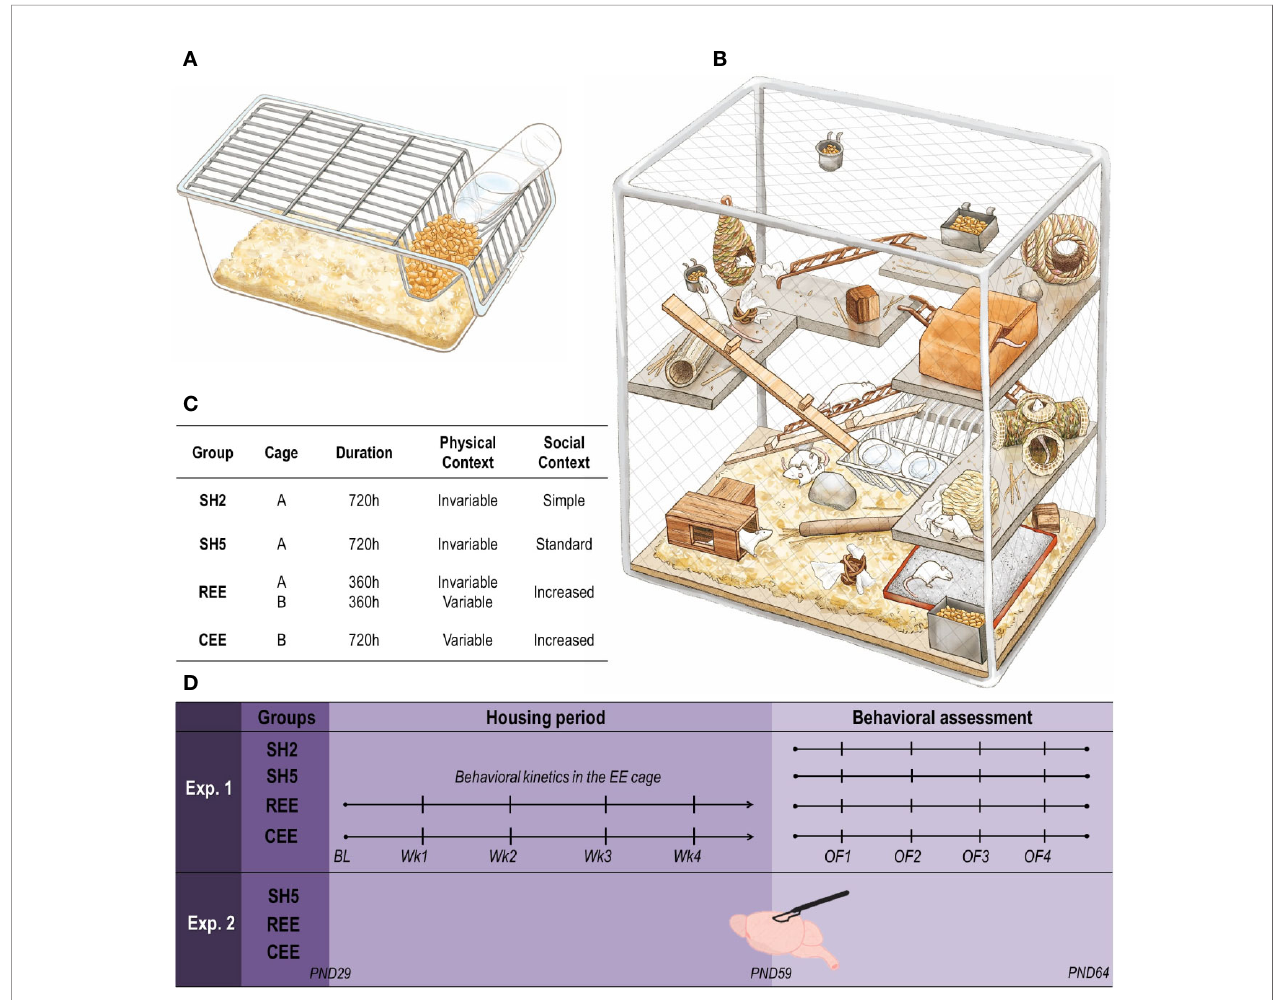
FIGURE 1 | Housing conditions and experimental design. (A) Transparent, polycarbonate cage (56 cm × 35 cm × 20 cm) fi lled with ~5 L of bedding for standard housing (SH). (B) Custom-made (135 cm × 68 cm × 110 cm), environmental enrichment (EE) cage surrounded by wire-mesh walls consisting of four stainless steel levels interconnected by metal and wooden stairs. The cage contained dens, hideouts, nesting and chewing materials, different objects for sensorimotor stimulation, feeders, and two bottles of water (for details see Table 1 ). The fi rst fl oor was always covered with bedding and had a sandbox. No running wheels were used. (C) Distribution of groups (n = 10 rats per group). SH2: pair-housed rats in SH cages; SH5: fi ve rats per cage in SH cages; CEE: ten rats per cage exposed continuously to EE throughout the 30-days protocol (~720 h), except during bed changes (30 min) when rats were housed in groups of fi ve in SH cages; REE: 10 rats per cage with restricted and unpredictable access to the EE cage during ~360 h (50% of the CEE total time). For the REE rats, the time in the cage was equally distributed between the light and dark cycle, with exposures to the EE cage ranging randomly from 2 to 48 h. During the non-EE periods, these animals were also housed in groups of fi ve in SH cages. CEE and REE rats were housed in independent EE cages. In order to control the increased handling experienced by REE rats, both SH groups and CEE rats were also handled each time REE rats were put in and out the EE cage: while SH2 and SH5 animals were relocated into new cages, CEE rats were group-housed in SH cages ( fi veper cage) during 5 min and then returned into the EE cage. (D) Experimental design. Housing conditions started at postnatal (PND) 29 and continued throughout 30 days. In experiment 1, behavioral activity and USVs within the EE cage were measured once a week (Wk) after bed changes. At PND 59, animals were tested on four, one-day apart open- fi eld (OF) tests for 15 min. In experiment 2, SH5, CEE, and REE groups were included (n = 10 rats per group) and animals were housed exactly as in experiment 1. No behavioral assessments were carried out to these animals. At PND 59, rats were euthanized, and their brain tissues were collected for mRNA quanti fi cation of BDNF, TrkB, CREB, p250GAP, and DNMT3A genes on the hippocampus, the dorsal striatum, and the nucleus